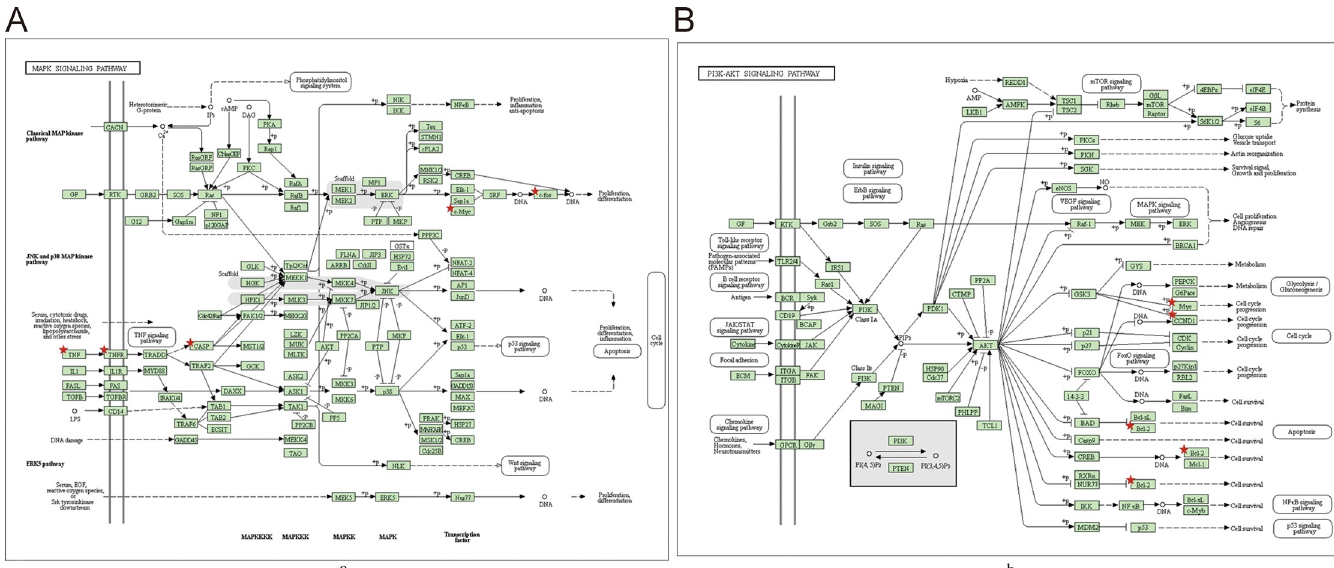
Fig 5. KEGG enrichment diagram. (A) MAPK signaling pathway. (B) PI3K-AKT signaling pathway. Red asterisks represent core targets.